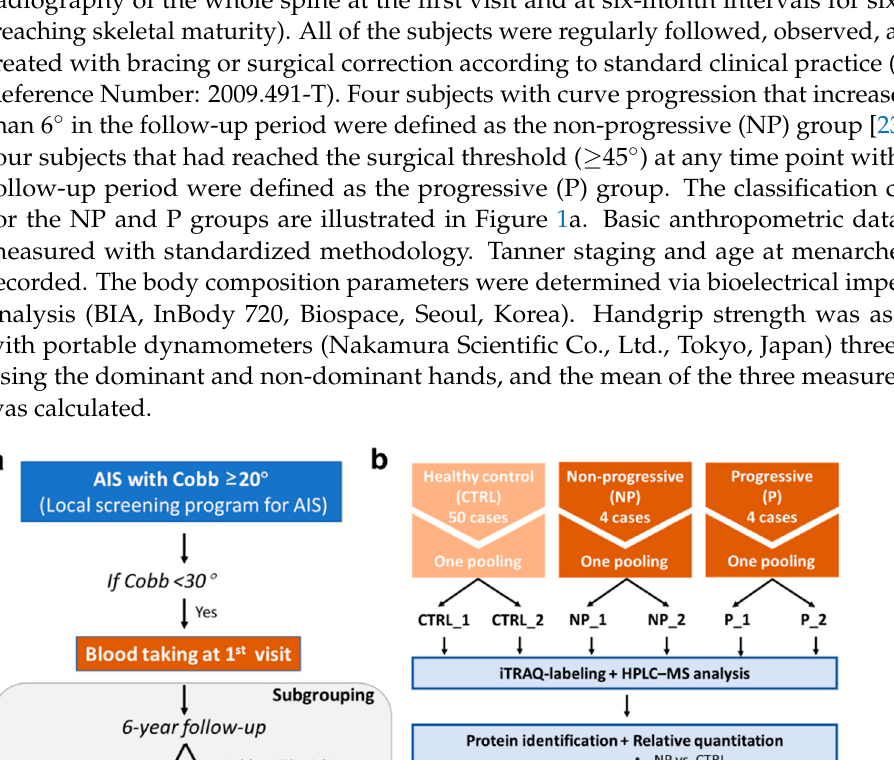
Table 1. Basic information for the three groups. Groups